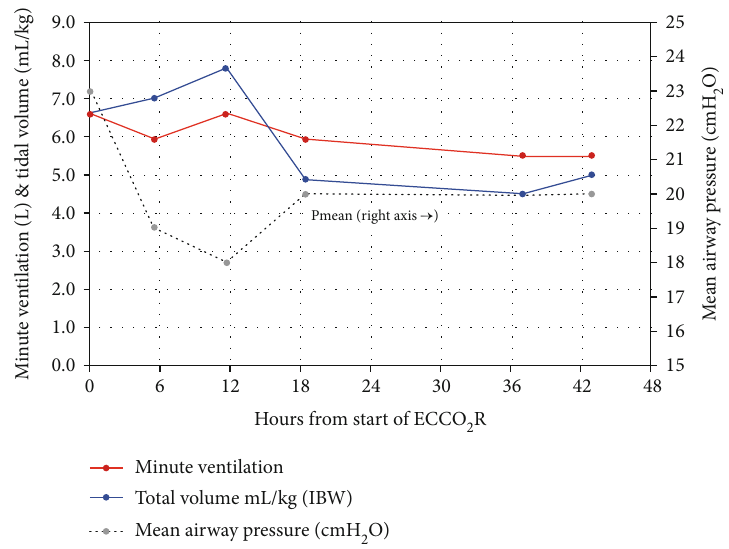
Figure 2: Mechanical ventilation during the fi rst 48 hours of Hemolung